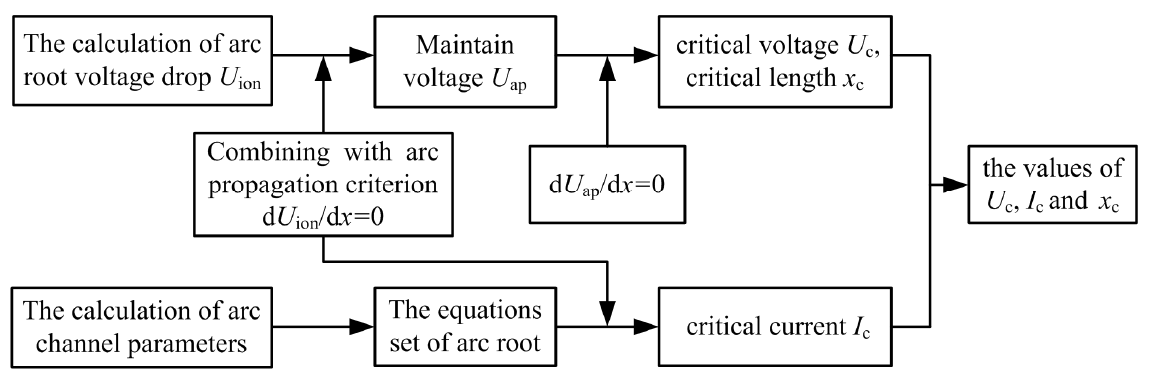
Figure 4. The calculation flowchart of critical flashover